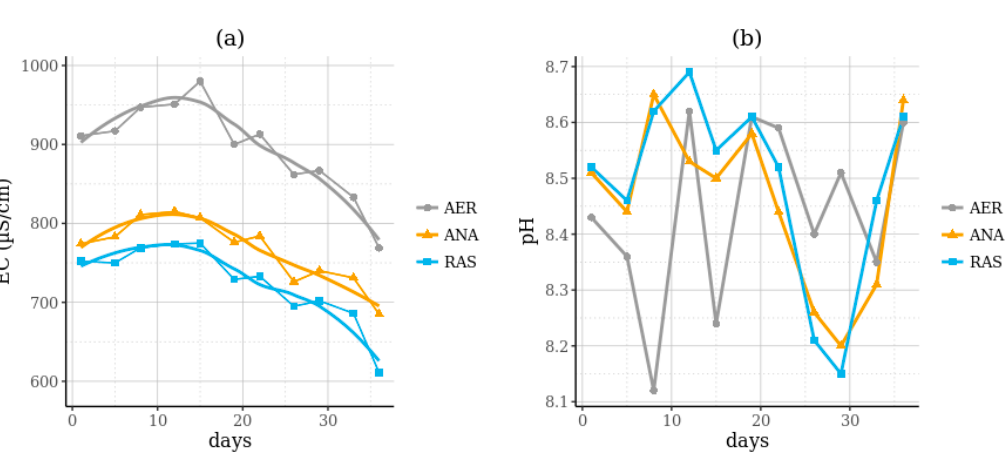
Figure 2. Variation of ( a ) electric conductivity (EC) and ( b ) pH (on a scale from 8.1 to 8.7) in the sump of the aerobic (AER), anaerobic (ANA), and RAS systems over the 35-day experimental period.